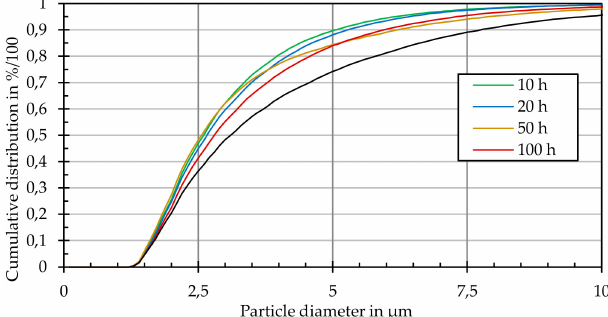
Figure 17. Change in the visible particle diameter in the period up to 1000